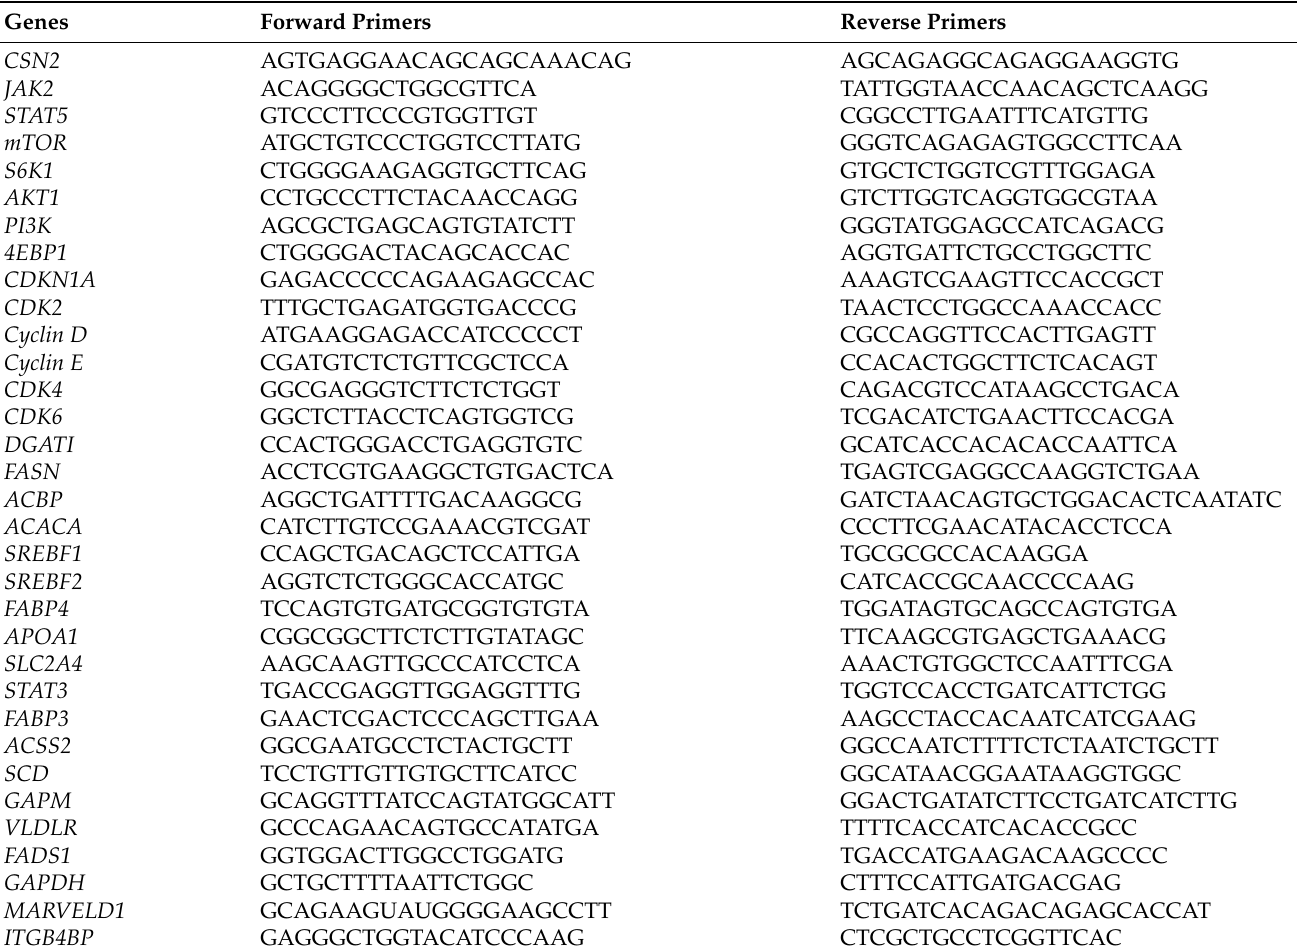
Table 2. Primers for